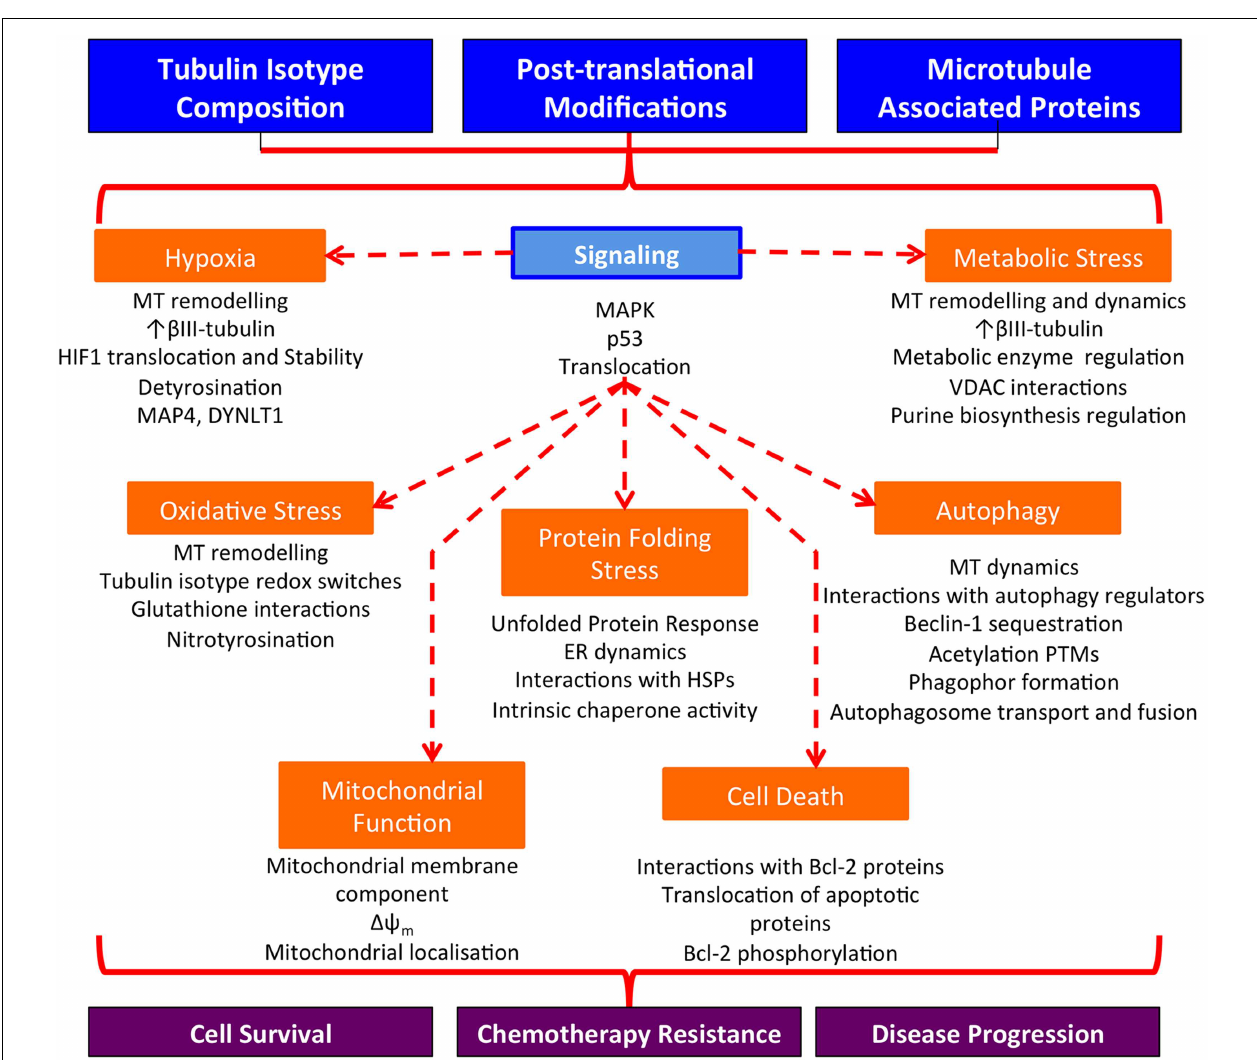
response to cellular stress. Microtubules may function to co-ordinate stress responses across the cell, resulting in enhanced cell survival in the harsh tumor microenvironment, resistance to chemotherapy treatment, and the development of more aggressive disease; MT,